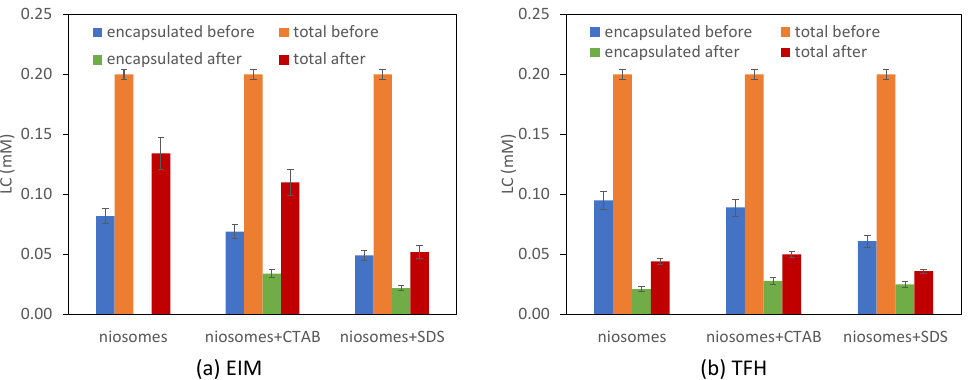
Figure 7. Loading capacity of Vanillin, total and encapsulated, before and after lyophilization process for ( a ) vesicles prepared by EIM method and ( b ) vesicles prepared by TFH method.